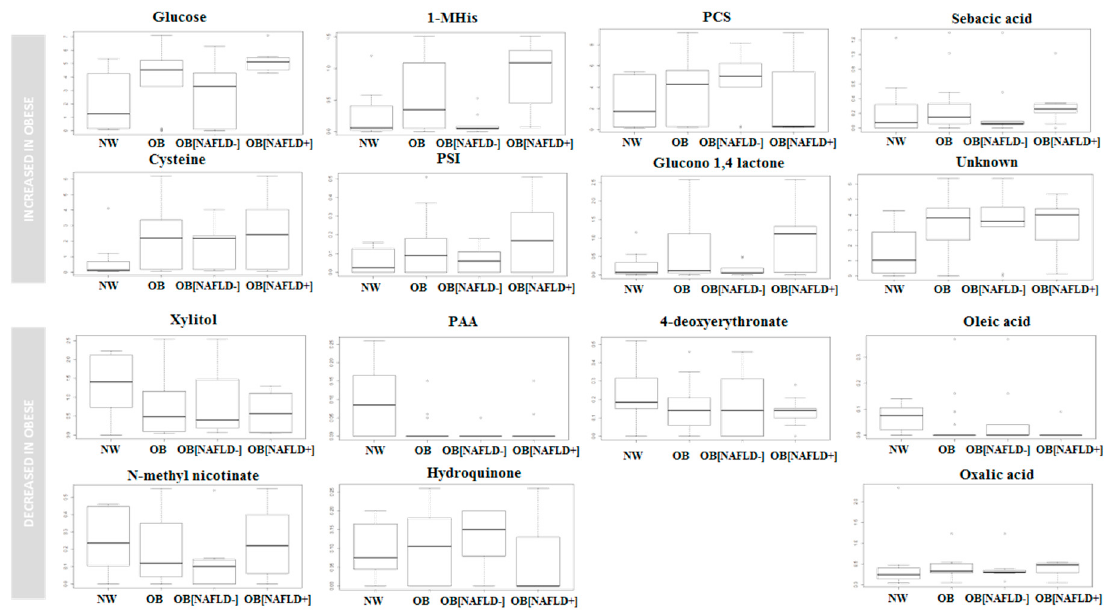
Figure 2. Box and Whisker plot of the VIP metabolites in the cohort of patients. Boxes represent normal weight controls (NW) N = 14; all the obese children (OB), N = 22; obese children without fatty liver (OB[NAFLD − ], N = 10), and obese children with fatty liver (OB[NAFLD+], N = 12). The vertical axis reports the log of the GCMS value of the normalized area of each metabolite. Abbreviations: Gas Chromatography Mass Spectrometry (GCMS), 1-Methyl histidine (1-MHis), Normal weight (NW), Obese (OB), Phenylacetic acid (PAA), P-cresylsulphate (PCS), Pseudouridine (PSI), with (NAFLD+) without (NAFLD − ) NAFLD. Table 2. Stepwise multivariate regression for WCE, L/M and KID-MED as dependent variable. Beta Std.Err. p -Value